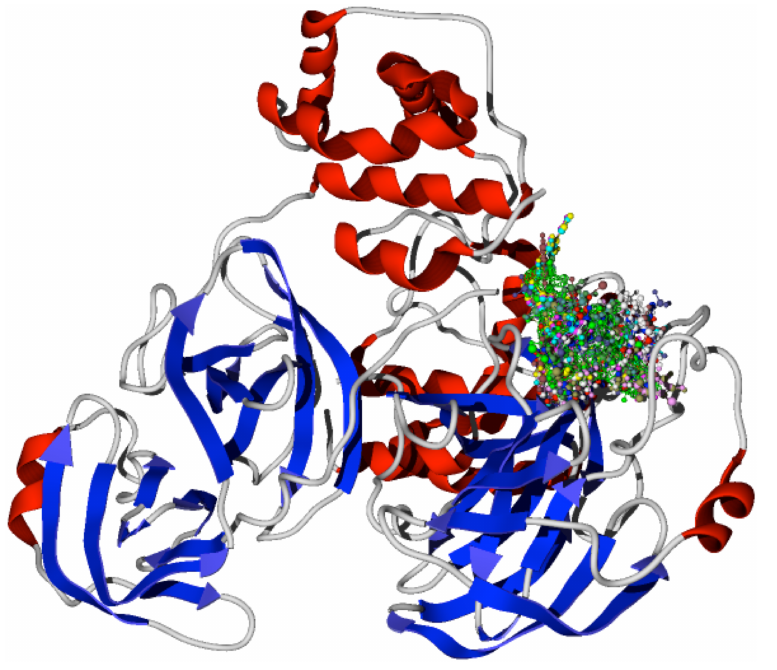
Figure 2 Docking of the 1,5-disubstituted tetrazole-1,2,3-triazoles with the protein CoV-2-M Pro